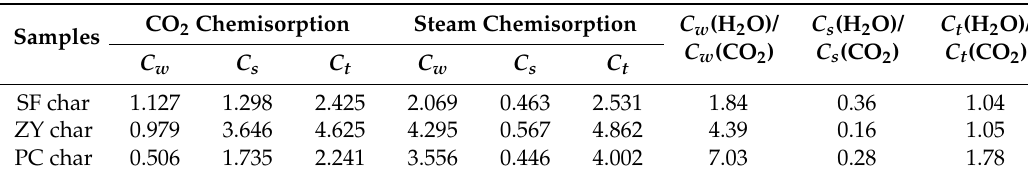
Table 3. Chemisorption parameters of tested